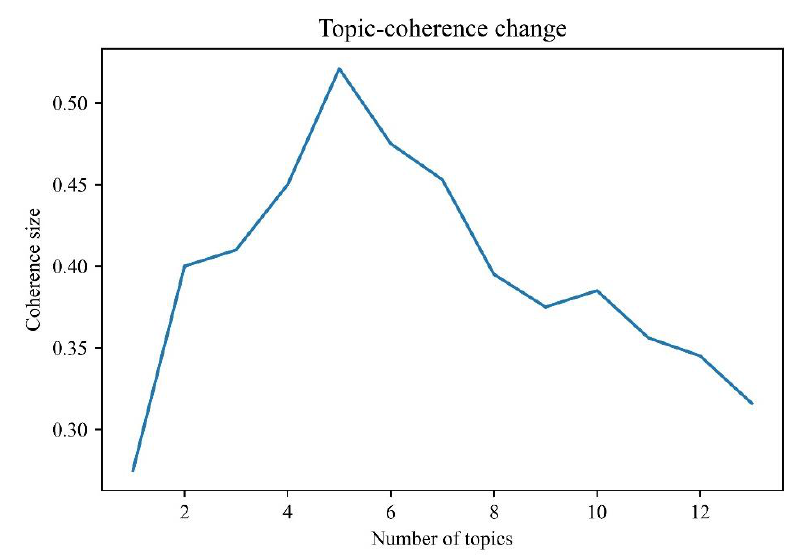
Figure 4. Coherence score for the different number of topics.